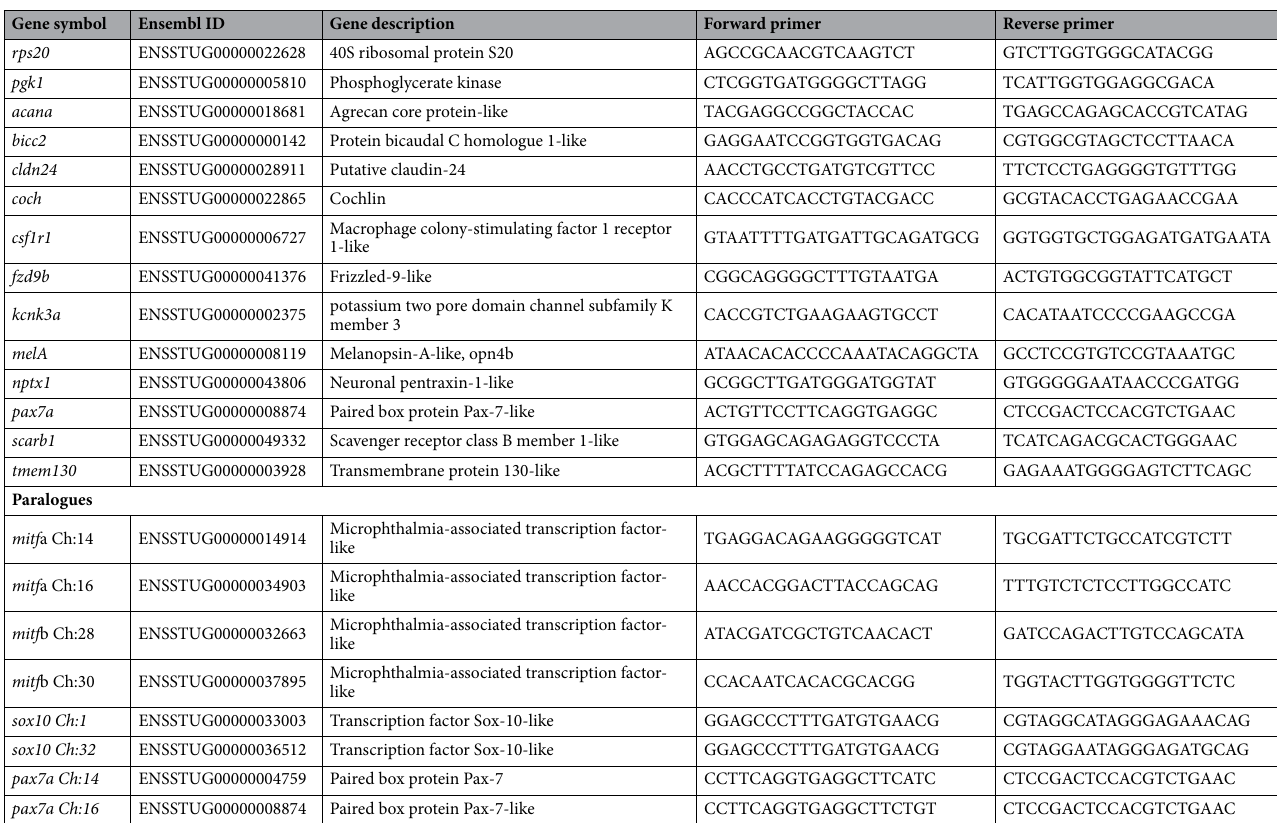
Table 2. The primers used for qPCR. Rps20 and pgk1 are housekeeping genes. The original primers are listed in alphabetical order according to the gene name. The second half of the table lists the primers for specific amplification of paralogue gene